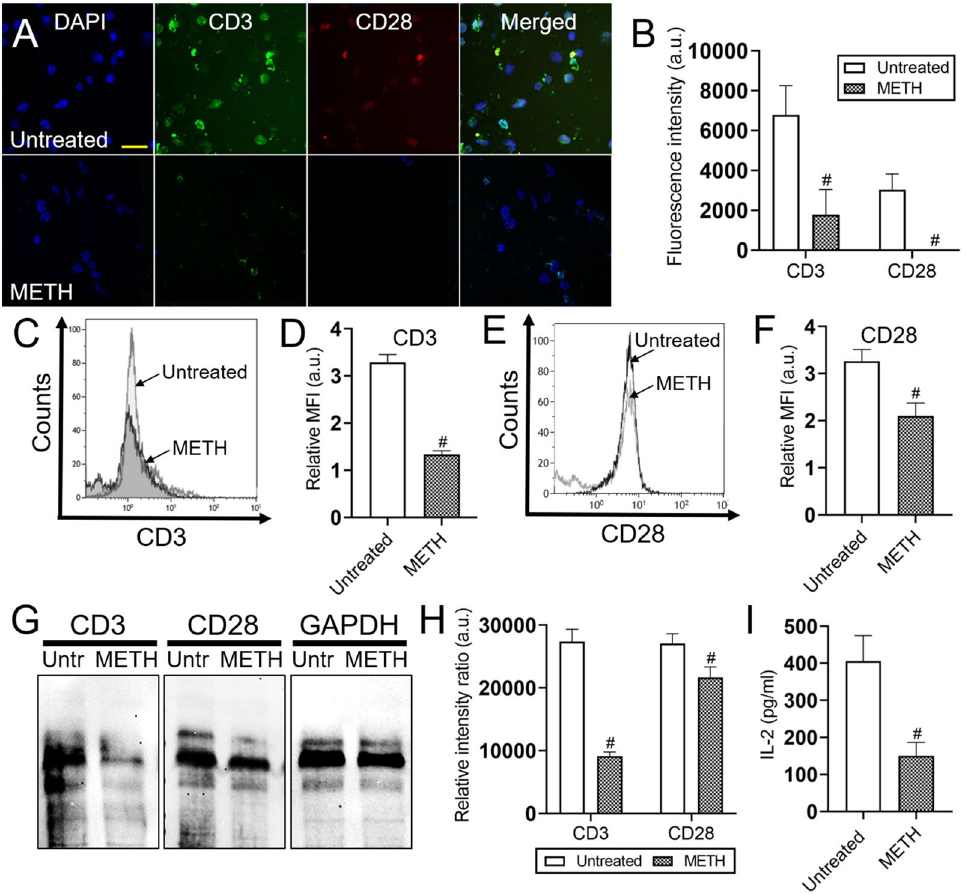
Figure 7. METH reduces the distribution and expression of CD3 and CD28 molecules on the surface of human Jurkat T cells. (A) Immunofluorescent images show the distribution of CD3 (green; anti-CD3 conjugated to Alexa Fluor 488) and CD28 (red; anti-CD28 conjugated to APC) on the surface of untreated (upper panel) and METH-treated (lower panel) Jurkat T cells. Nuclei of T cells were stained in blue with dapi. Scale bar, 20 μm. (B) The CD3 and CD28 fluorescent intensity of untreated and METH-treated Jurkat T cells was analyzed. Bars represent the mean of 10 cell measurements and error bars indicate STDEV. The number sign (#) denotes P value significance ( P < 0.05) calculated using student’s t -test analysis. The mean fluorescence intensity (MFI) of (C,D) CD3 and (E,F) CD28 molecules on Jurkat T cells was analyzed by flow cytometry. A density of 2 × 10 5 Jurkat T cells was treated with 25 μM METH for 2 h. Representative histograms of untreated and METH-treated Jurkat T cells are shown. Each plot was generated after 10,000 events were analyzed. The relative MFI of IgM receptor was analyzed. (G) The expression of CD3 and CD28 in Jurkat T cells was determined by western blot analysis. T cells were cultured with 25 μM METH for 2 h. GAPDH was used as a housekeeping gene control. Both conditions (Untreated and METH) were run in the same gel next to each other and processed in parallel. We cropped each gel to improve the clarity and conciseness of the presentation. Original full-length gels are presented in Supplementary (S) Fig. 1A (CD3), SFig. 1B (CD28), and SFig. 1C (GAPDH). (H) The levels of expression of CD3 and CD28 were measured by determining the relative intensity ratios. Individual band intensities from the western blot were quantified using ImageJ software. The GAPDH gene was used as a reference to determine the relative intensity ratios shown in panel H . (I) Twenty-four hours culture supernatants from untreated and METH-treated Jurkat T cells stimulated with a mixture of 50 ng/ml phorbol myristate acetate (PMA), 1 μg/ml ionomycin, and 30 μg/ml phytohemagglutin-L (PHA) were analyzed for IL-2 production by ELISA. For graphs in D , F , H , and I , bars represent the mean of 3 independent experiments ( n = 3) and error bars indicate STDEV. The number sign (#) indicates P value significance ( P < 0.05) calculated using student’s t -test